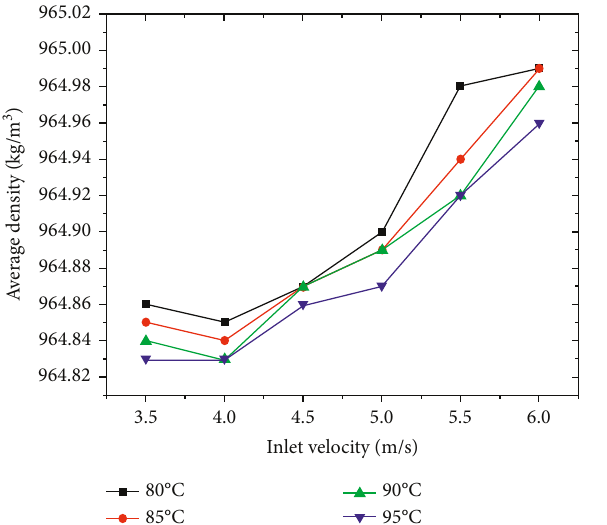
Figure 38: Inlet velocity and average density with temperature for 100% opening.